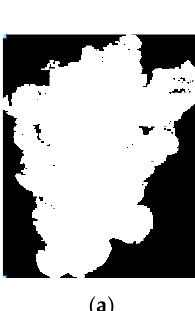
Figure 15. The length of the randomly selected grape clusters.